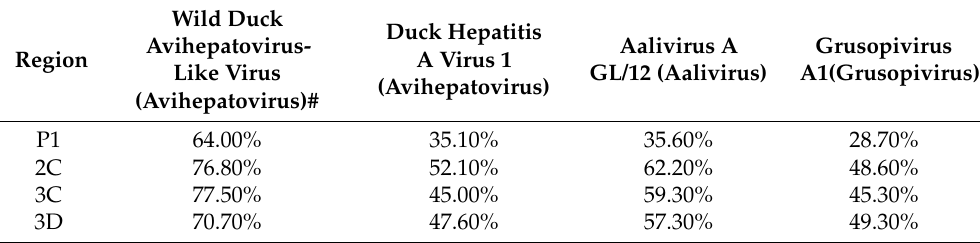
Table 1. Comparisons of Amino acid sequence homology of DERSV(AH204) with the closely related